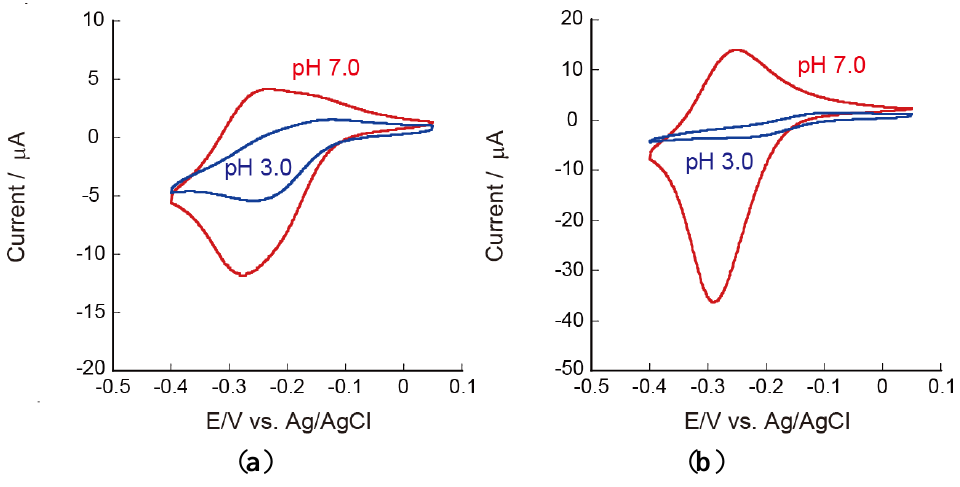
Figure 9. CVs of Ru(NH electrodes at pH 3.0 (blue) and pH 7.0 (red). The LbL films were prepared at pH